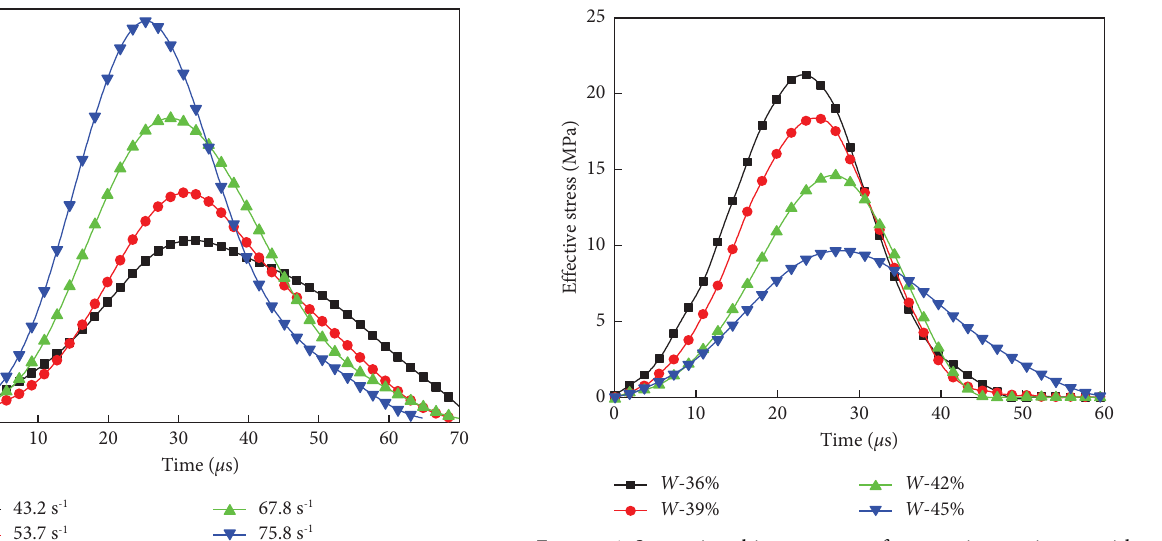
Figure 6: Stress-time history curve of composite specimens with diferent moisture contents when d is 6